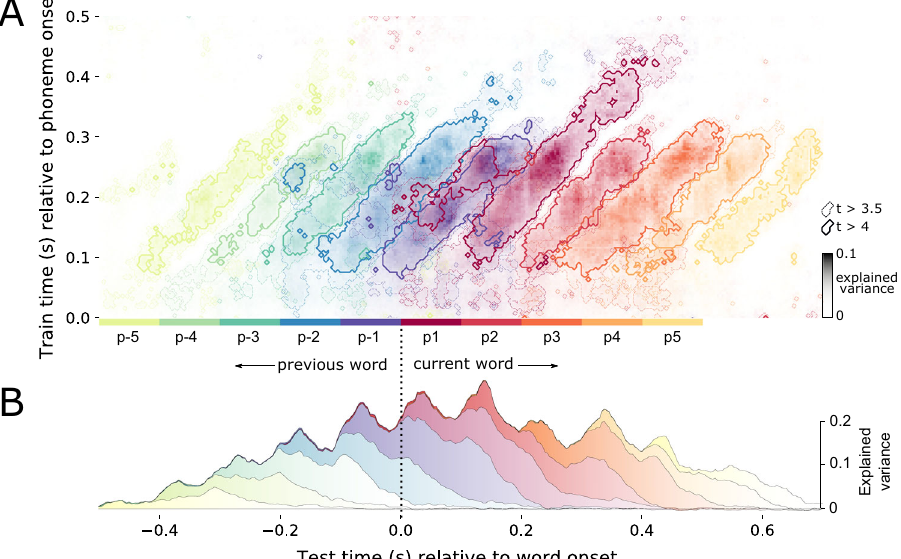
Fig. 3 | Phonetic feature processing across the sequence. A Temporal general- isation (TG) results superimposed for 10 phoneme positions. Results represent decoding performance averaged over the 14 phonetic features. From the fi rst phonemeinaword(P1,darkred)movingforwards,andthelastphonemeinaword (P-1,darkblue)movingbackwards.Theresultforeachphoneme positionisshifted by the average duration from one phoneme to the next. The y -axis corresponds to the time that the decoder was trained, relative to phoneme onset. The x -axis cor- respondstothetimethatthe decoderwastested,relativetoword onset.Contours represent a t -value threshold of 4 (darker lines) and 3.5 (lighter lines). Note that